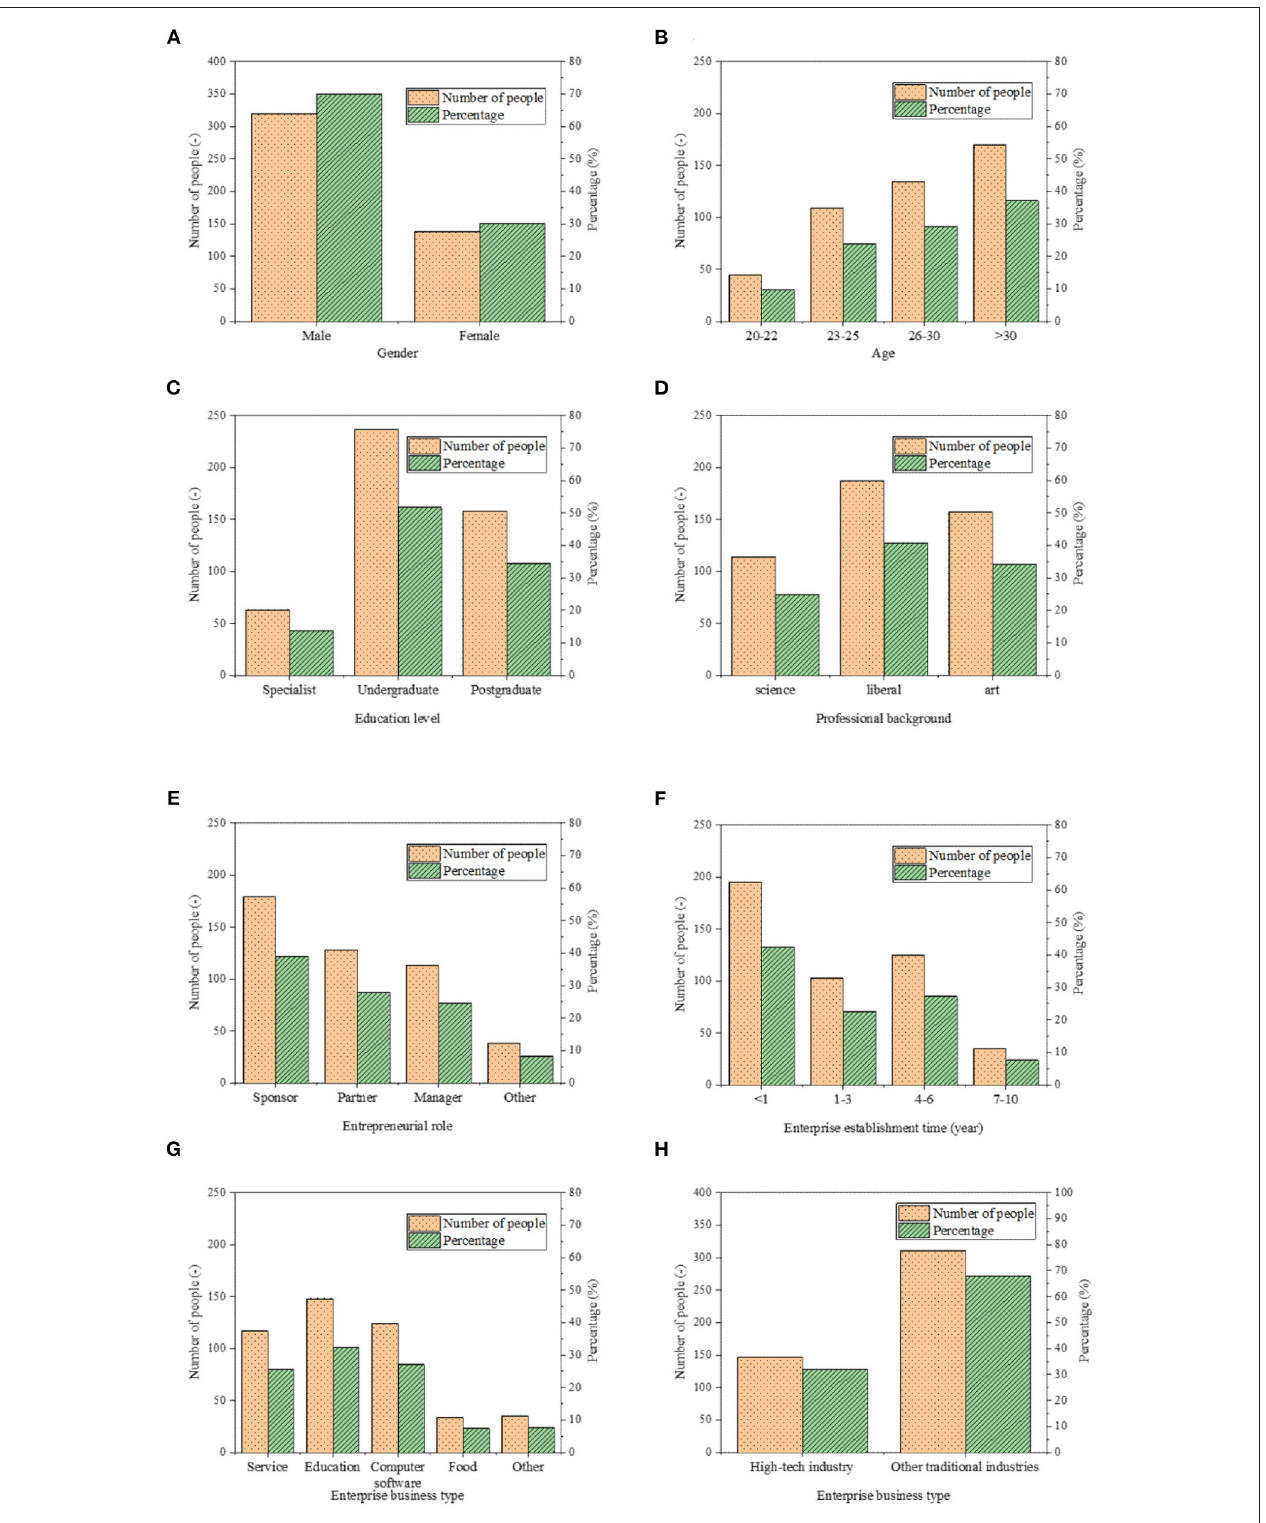
FIGURE 6 | Statistics of the basic information of new venture entrepreneurs and new ventures: (A) gender; (B) age; (C) education level; (D) professional background; (E) entrepreneurial role; (F) enterprise establishment time; (G) enterprise business type; and (H) enterprise industrial nature.